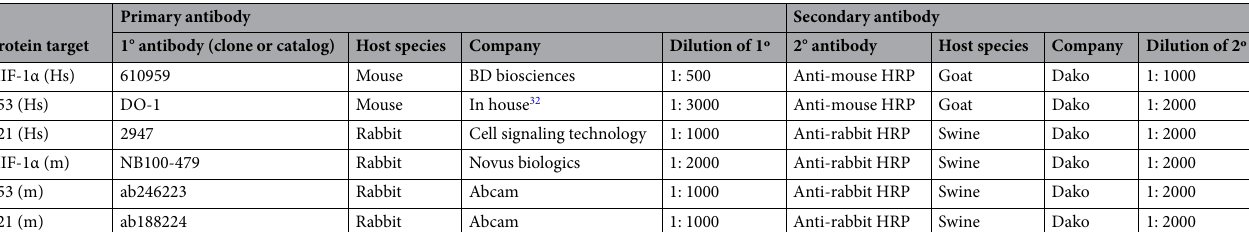
Table 2. Dilutions of primary and secondary antibodies used for immunoblotting detection of proteins involved in hypoxia and p53 activation in human and mouse cancer cell lysates. HIF-1α hypoxia inducible factor 1α, Hs human, m